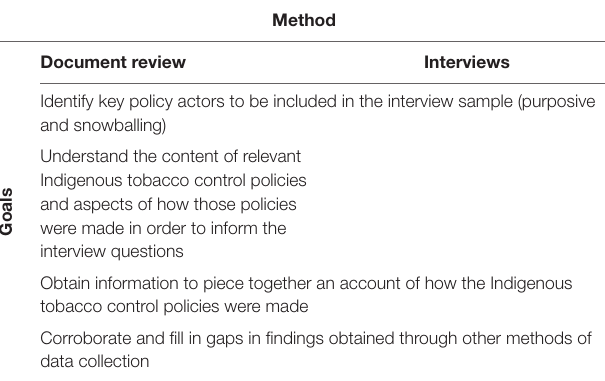
TaBle 1 | summary of goals of data collection, by